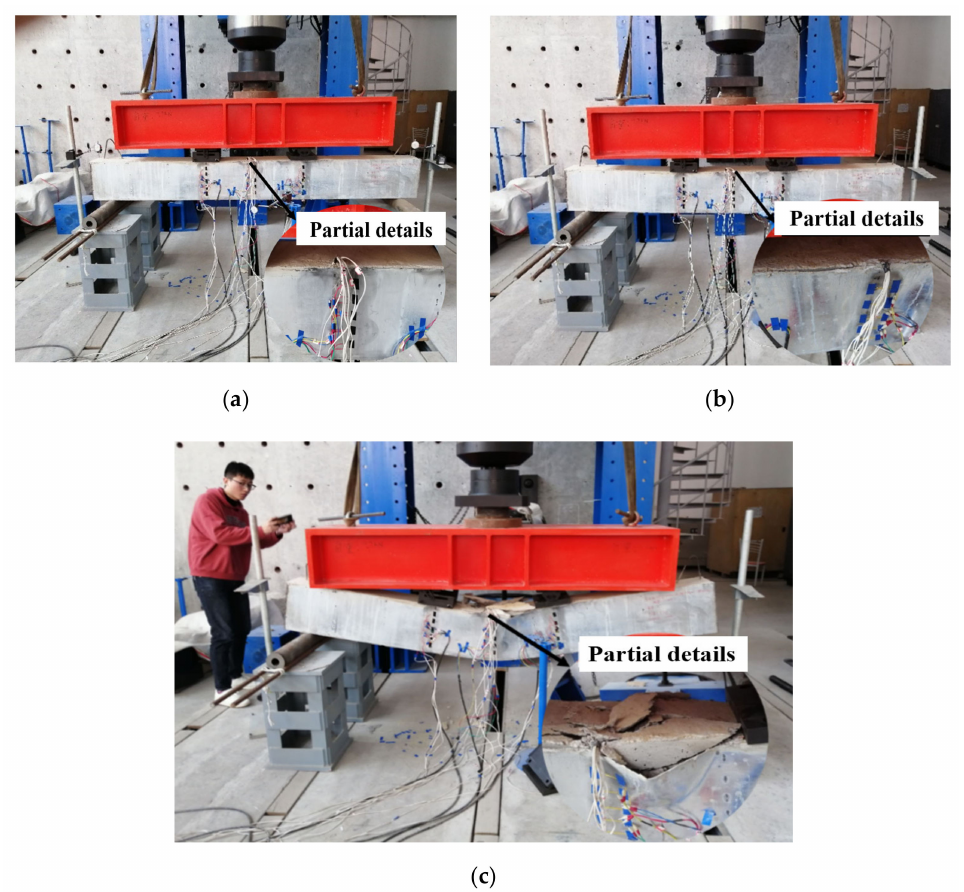
Figure 6. Destruction diagram of composite beam specimen: ( a ) Close attachment stage; ( b ) Micro- detachment stage; ( c ) Failure stage.